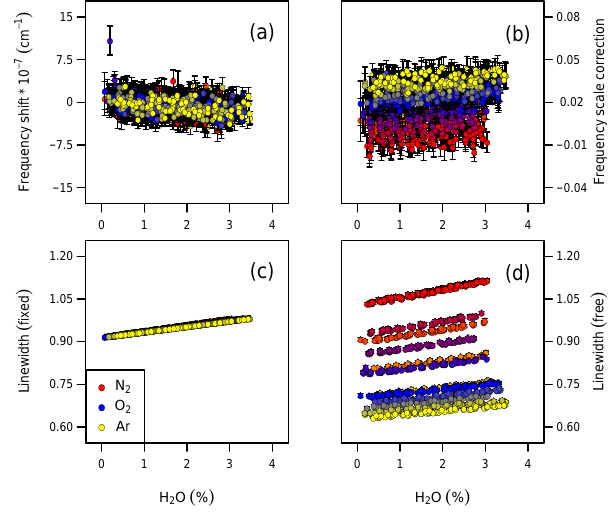
Figure 11. Relationships between H 2 O mixing ratio and the fre- quency shift, frequency scale correction, fixed linewidth, and free linewidth parameters. For each panel, n = 990 measurements of four liquid standards across a range of injection volumes (i.e., 400– 2400nL, in 11 steps of 200nL each). Points represent mean values ± SD for replicates of each standard at each injection